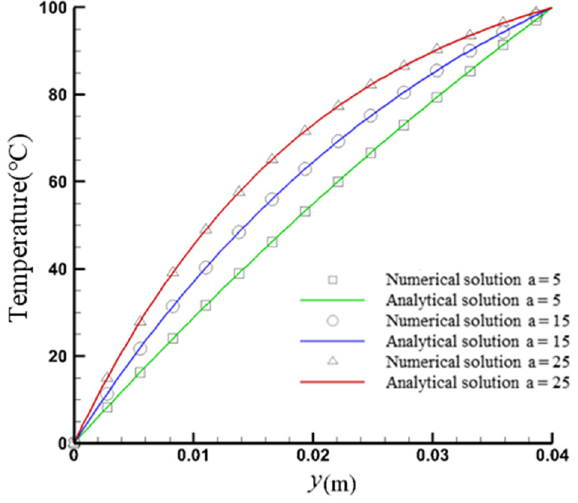
Figure 10. Numerical and analytical solutions of temperature along the y-direction for steady-state heat conduction with different gradient coefficients under exponential distribution.